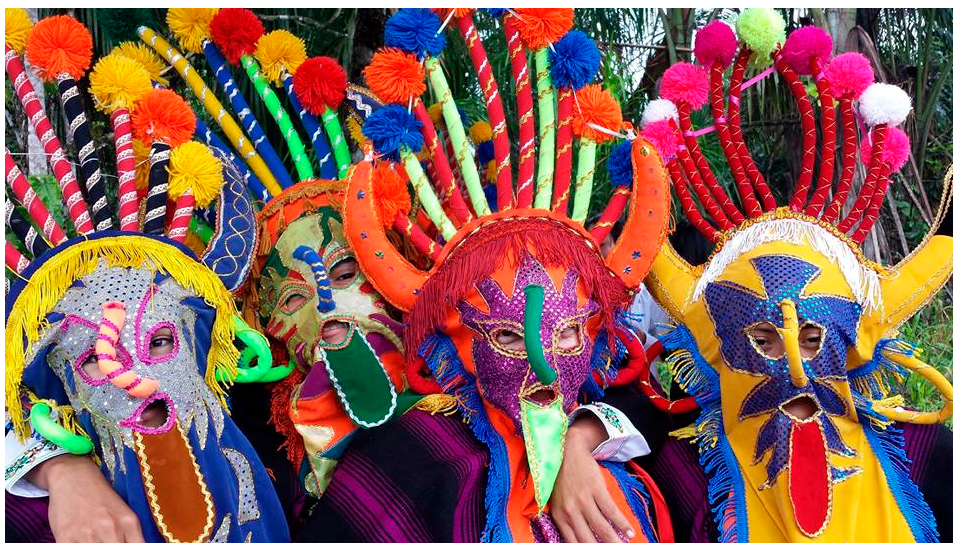
Figure 3. The festivities in honor to the patron saint San Marcos in the San Marcos Community. Source: CASCOMI.